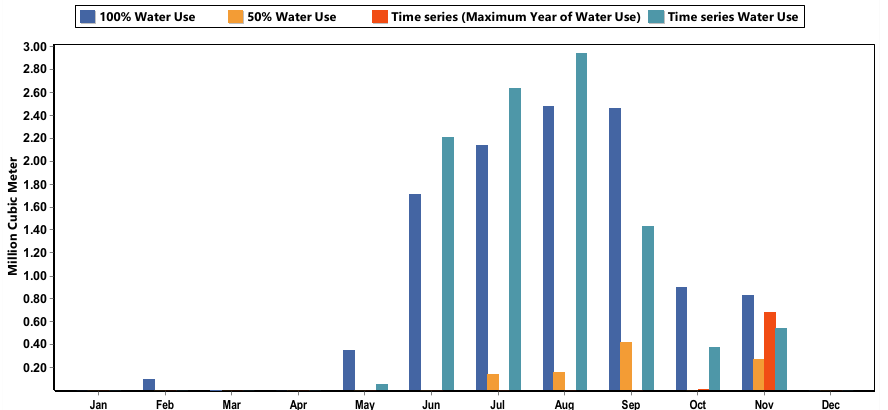
Figure 17. Average monthly unmet streamflow requirements (million cubic meter) in Chester weir for RCP85 future scenarios for the period of